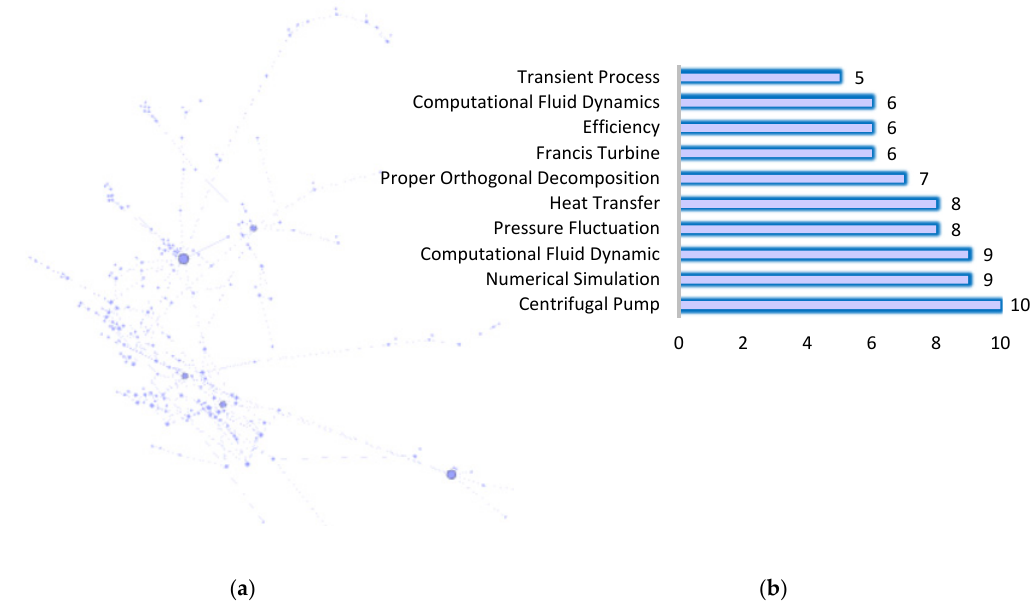
Figure 24 . Hydropower and energy storage: ( a ) manuscripts published, ( b ) keywords. Figure 24. Hydropower and energy storage: ( a ) manuscripts published, ( b )